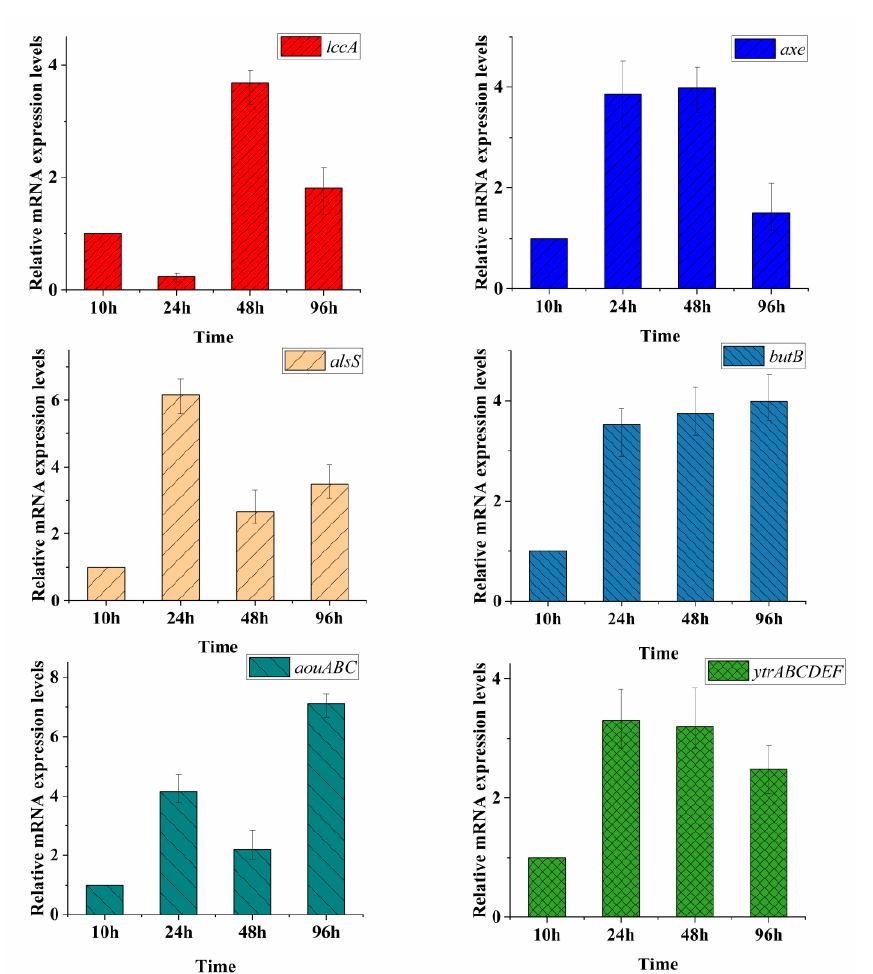
Figure 6. Relative mRNA expression levels of genes in the acetoin metabolite pathway. lccA : laccase; axe: acetyl xylan esterase; alsS : α -acetolactate synthase; butB : diacetyl reductase; acuABC : acetoin utilization protein; ytrABCDEF : ATP-binding cassette (ABC) transport system. The experiment was repeated three times, and the error bars corresponded to the standard deviation (SD).